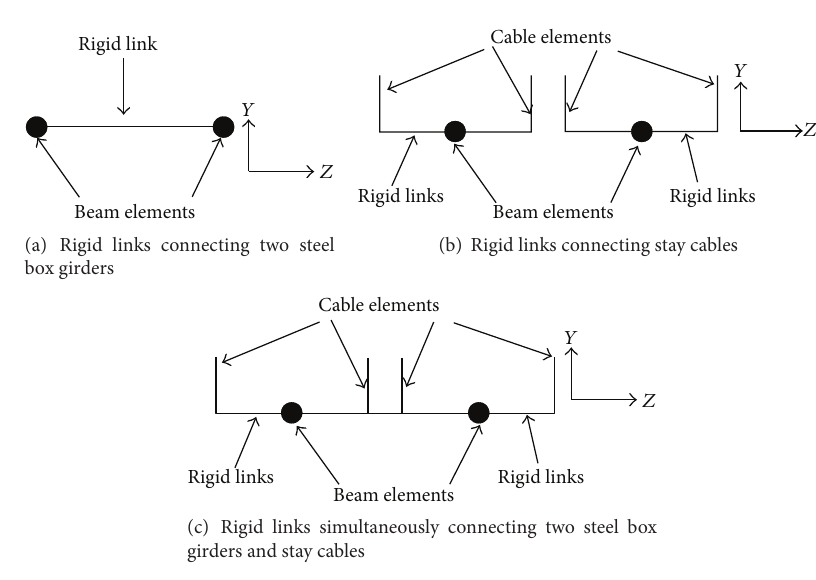
Figure 4: Detailed finite element modeling for rigid